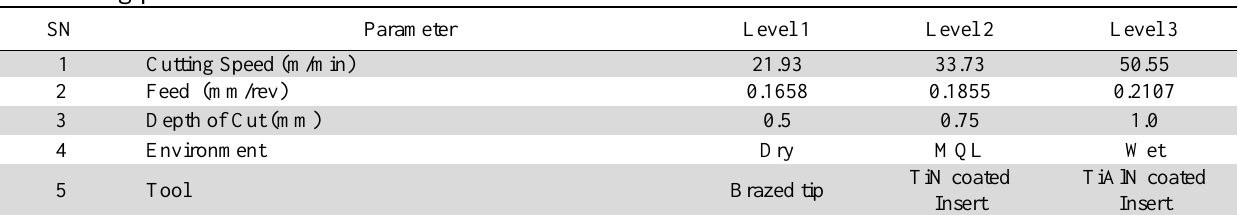
Machining parameters